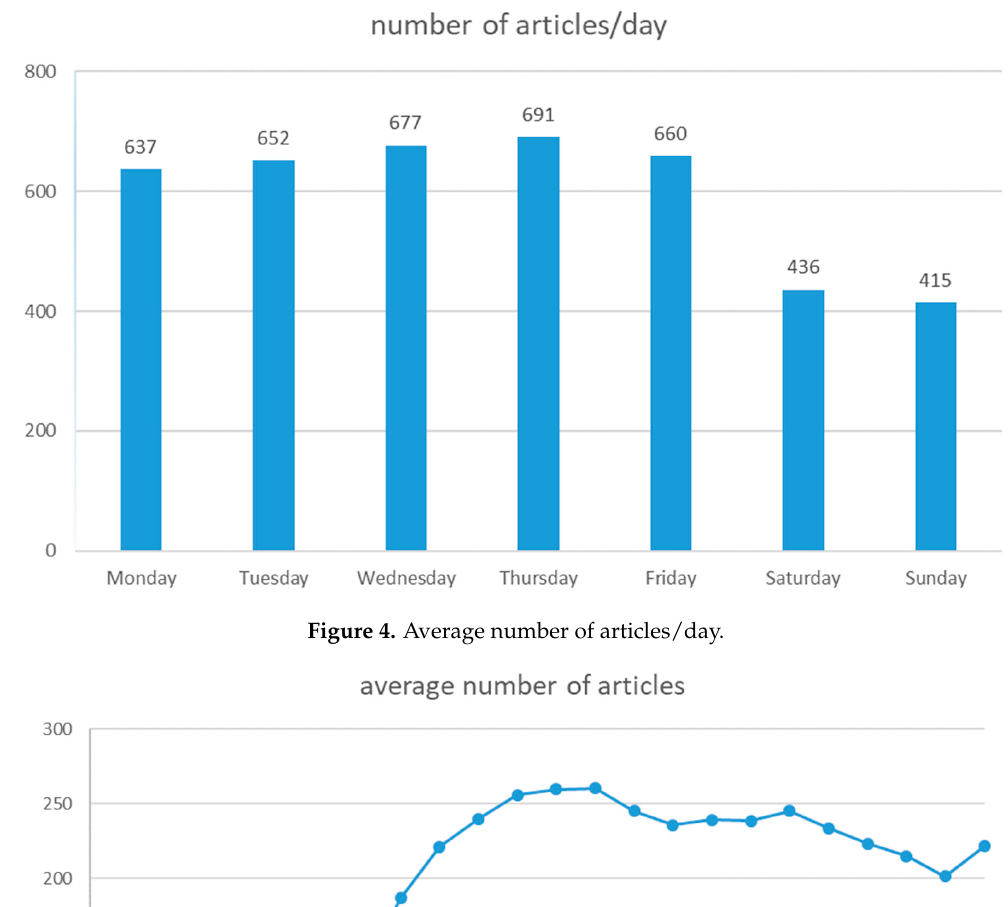
Figure 4. Average number of articles/day.